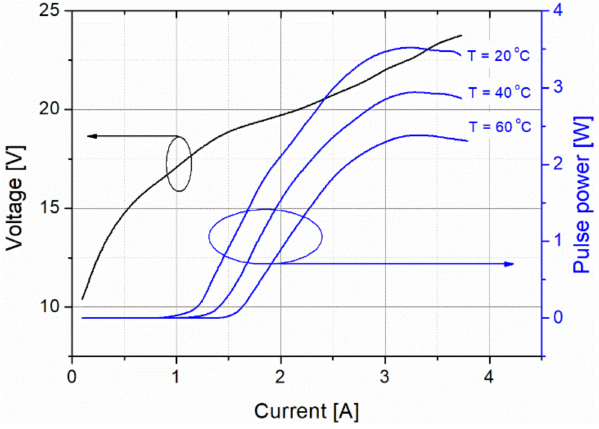
Figure 4. Characteristics of pulsed QC laser